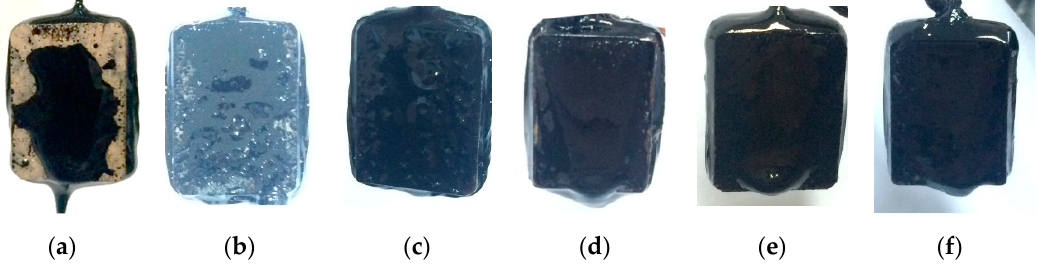
Figure 6. The specimens after modified stripping test: ( a – c ) control specimens with granite, basic rock, and limestone and ( d – f ) treated specimens with granite, basic rock, and limestone.